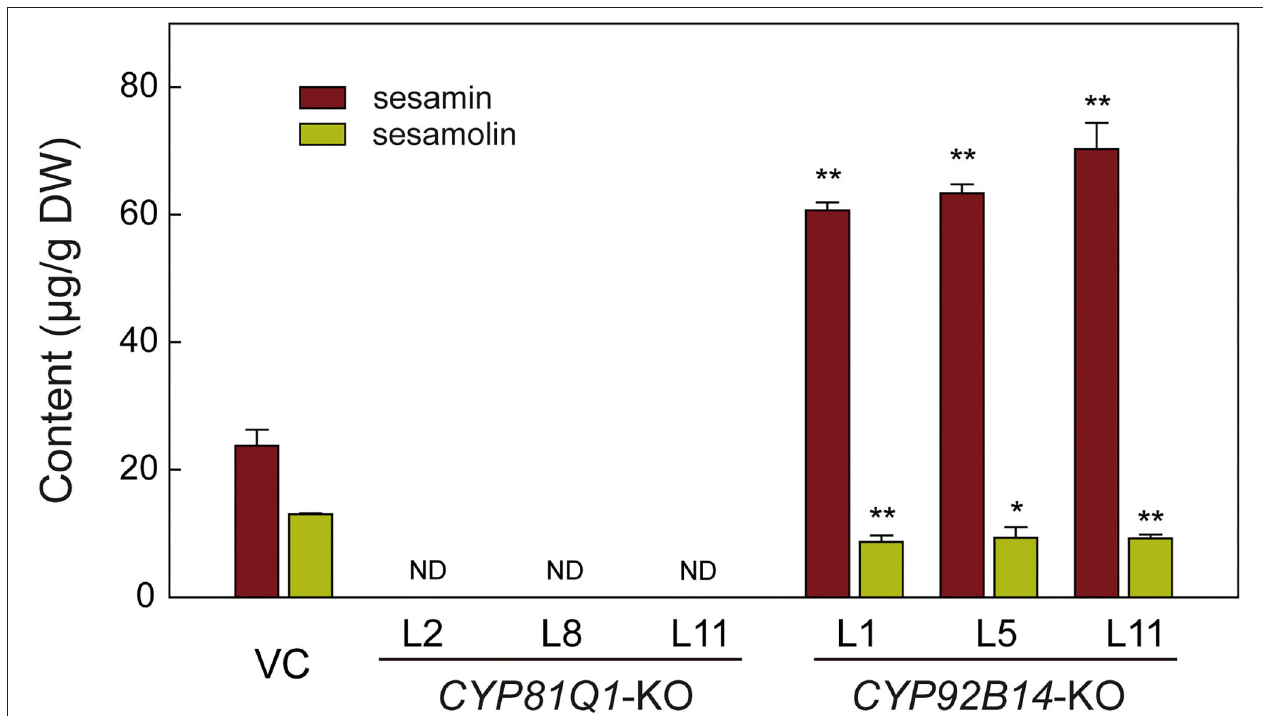
FIGURE 6 | Lignans content analysis in CYP81Q1 - and C YP92B14 -knockout hairy roots. The contents of two lignans (sesamin and sesamolin) in vector control (VC) lines, and the CYP81Q1 - and CYP92B14 -knockout (KO) lines. DW, Dry weight; ND, Not detected. Error bars designate the standard error ( n = 3), ** P < 0.01; * P < 0.05, t